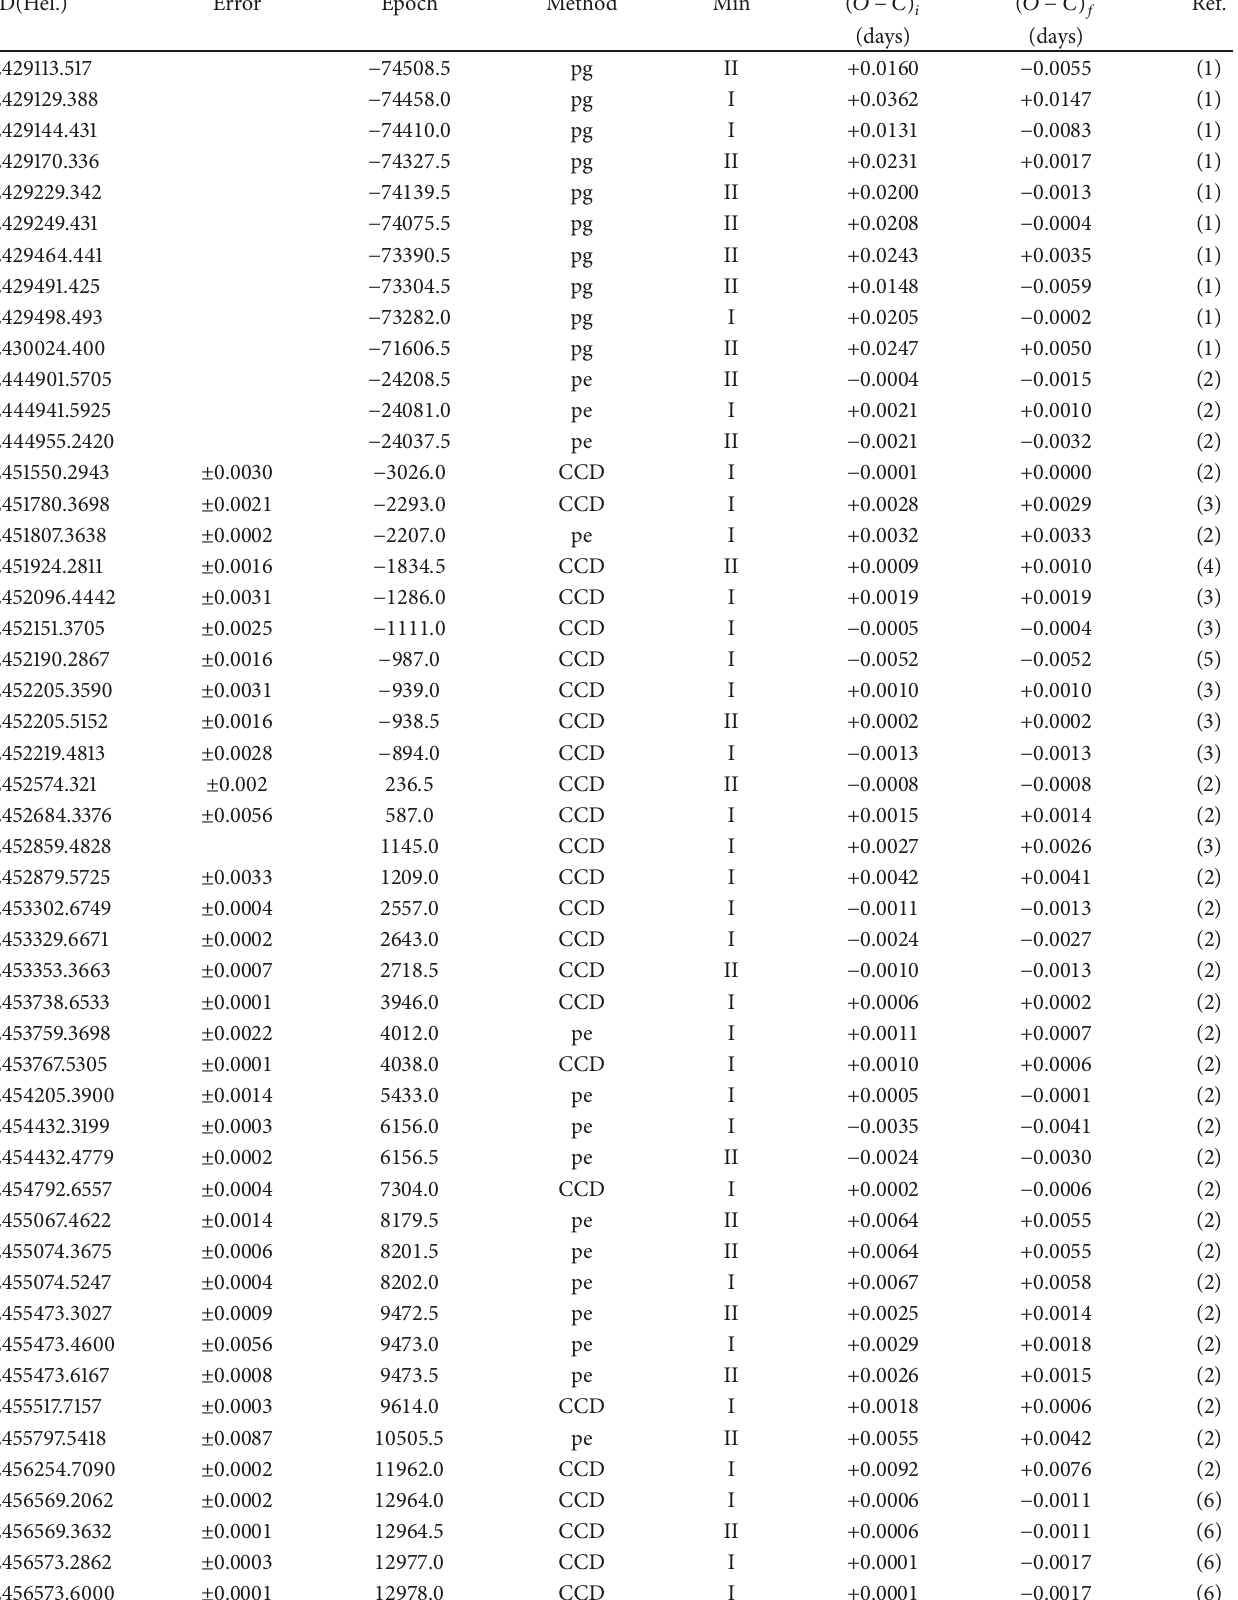
Table 3: All light minimum times for MT